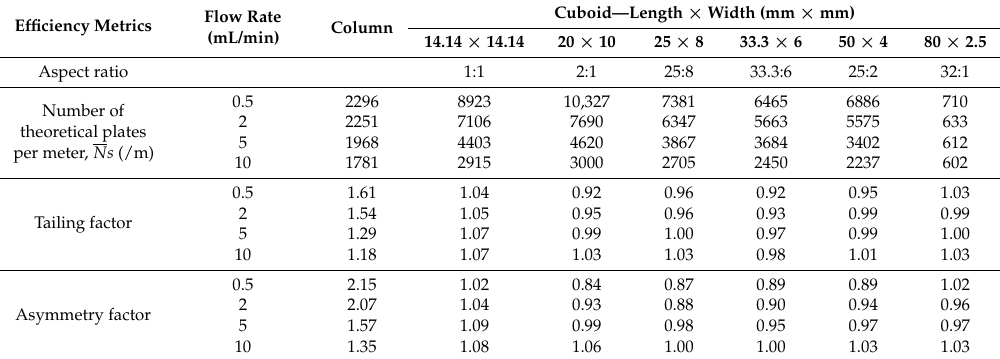
Table 1. The number of theoretical plates and attributes of salt peaks obtained with the different cuboid packed-bed devices and their equivalent column at different flow rates (media: Capto Q anion exchange, bed volume: 5 mL, mobile phase: 0.4 M NaCl, tracer: 0.8 M NaCl, loop: 0.1 mL, v S = 15, 60, 150 and 300 cm/h at flow rates of 0.5, 2, 5 and 10 mL/min respectively). Efficiency